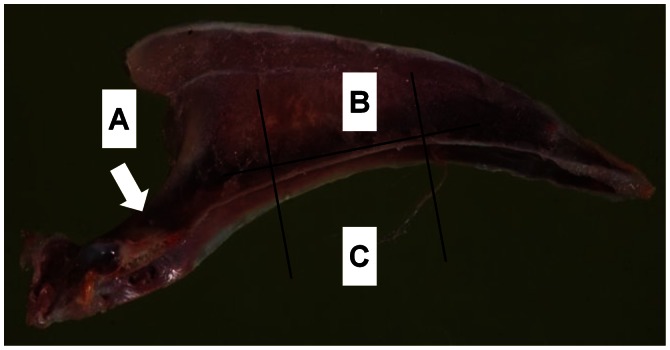
Areas of the keel for structural and biomechanical testing.Manubrial spine (A) for biomechanical testing where the arrow indicates the direction of applied force during biomechanical testing; lateral surface (B) and base (C) for bone mineral density quantification.